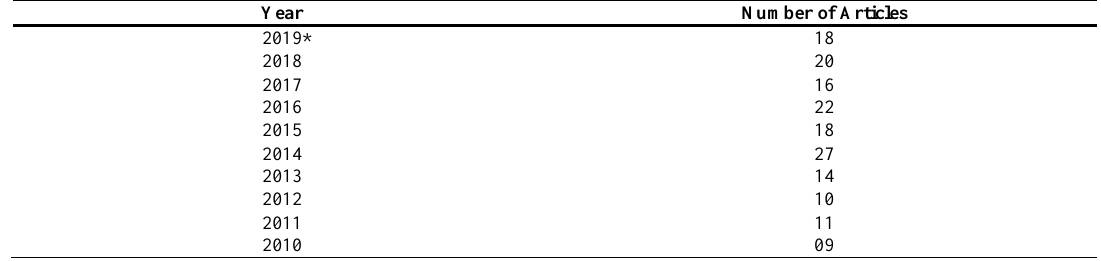
Table 2. Annual publications: intellectual capital and operational excellence